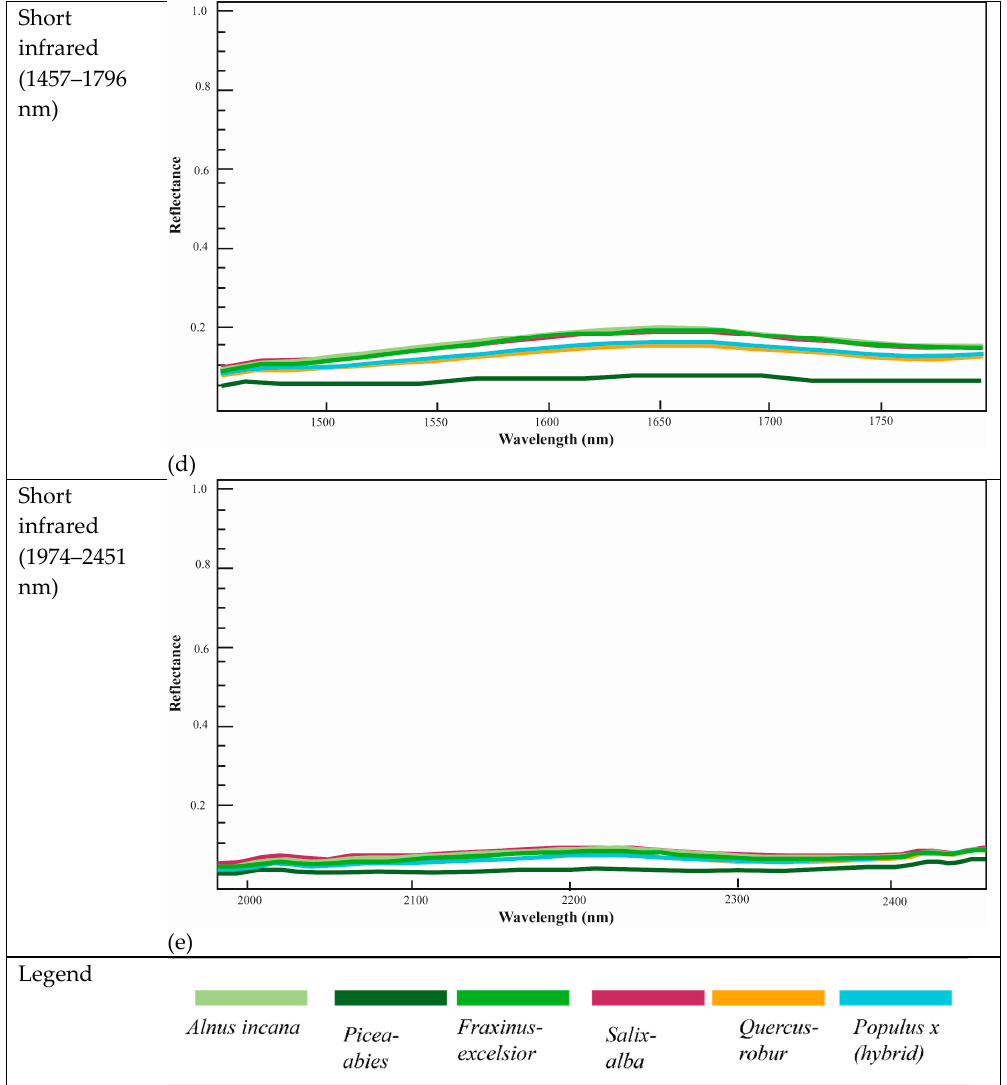
Figure 5. Subfigure ( a ) shows an illustration of spectra for each tree species using training samples and the APEX hyperspectral imagery; subfigures ( b – e )) show a detailed look at the spectra in the visible portion of the spectra (VIS; 413–700 nm), near-infrared (NIR; 700–1357 nm), near-short infrared